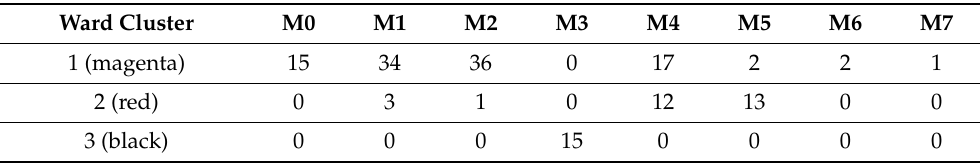
Table 1. Contingency table comparing Ward clustering of the RNA-Seq dataset and FAB classification